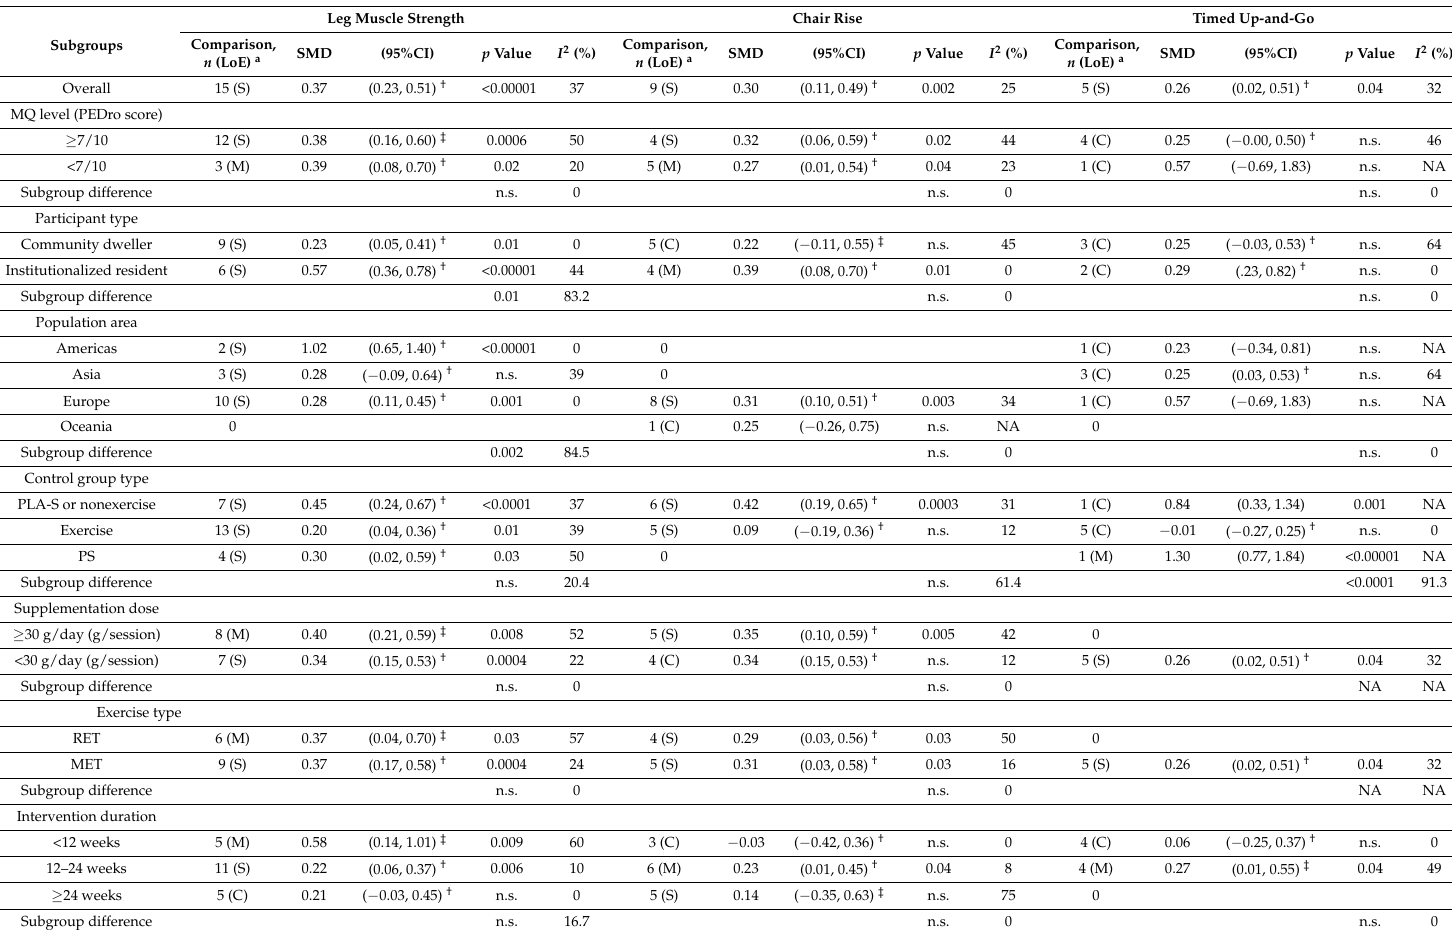
Table 5. Summary of overall effects and subgroup analysis results for physical